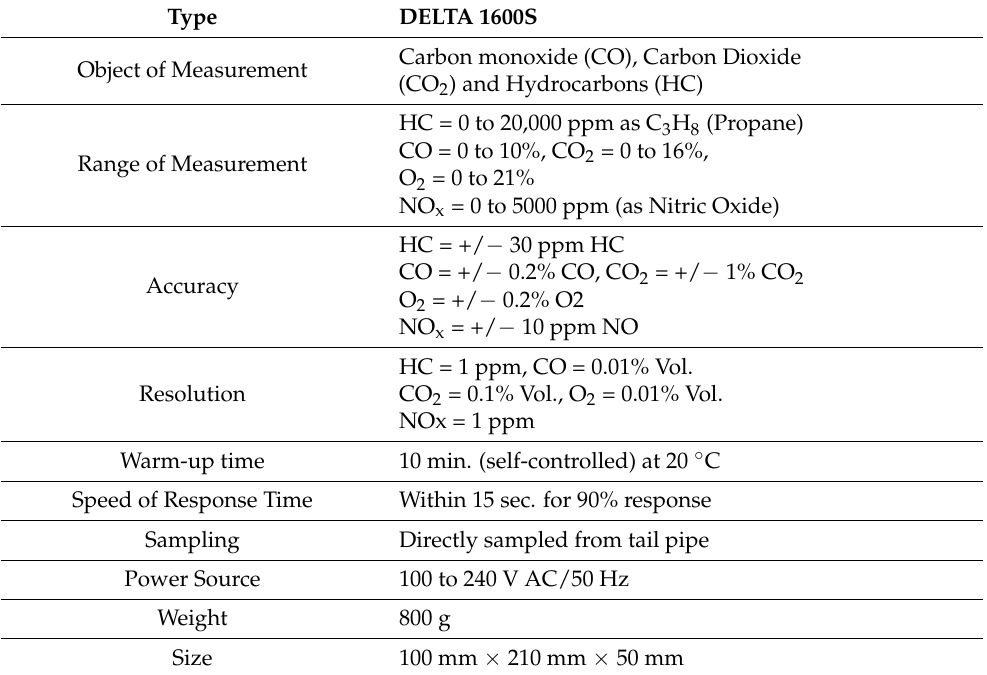
Table 5. Specifications of exhaust gas